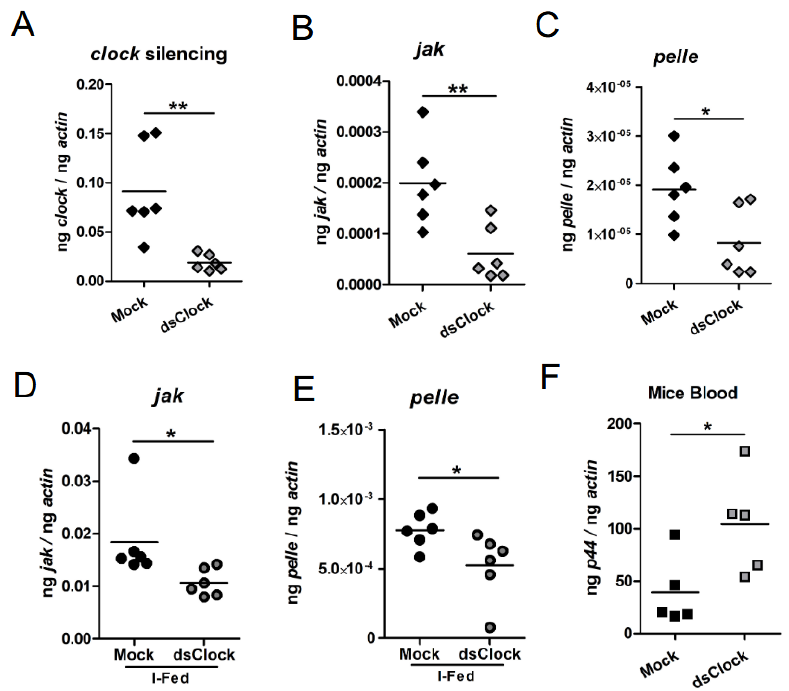
Figure 7. RNAi mediated silencing of arthropod clock increases bacterial transmission from ticks to mice. QRT-PCR analysis showing levels of clock ( A ); jak ( B ); and pelle ( C ) transcripts in mock-dsRNA or clock -dsRNA treated tick cells. Each rhombus indicates one tick. QRT-PCR analysis showing levels of jak ( D ); pelle ( E ) transcripts in mock-dsRNA or clock -dsRNA-injected ticks. In panels A, B, C, D levels of clock , jak and pelle transcripts were normalized to tick beta-actin levels. ( F ) QRT-PCR analysis showing bacterial burden in murine blood from mice fed with mock-dsRNA-injected or clock -dsRNA-injected A. phagocytophilum -infected nymphs. Bacterial burden was measured by quantifying amount of A. phagocytophilum p44 DNA levels normalized to mouse beta-actin levels. Statistical analysis was performed using Student’s t -test, and a p -value of less than 0.05 was considered significant. * p < 0.05 and ** p < 0.01.